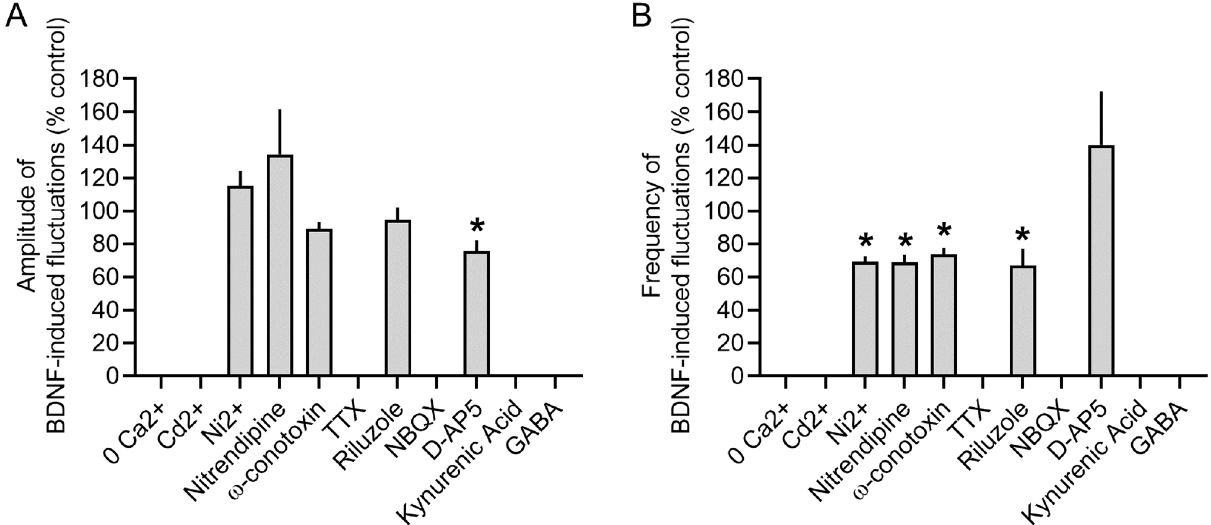
Figure 4. Pharmacology of [Ca 2+ ] i fluctuations from BDNF-treated cultures. Summary of the effects of various pharmacological treatments on the ( A ) amplitude and ( B ) frequency of the [Ca 2+ ] i fluctuations in BDNF-treated cultures compared to before drug treatment. Bars show the mean + standard error of the mean. * P < 0.001, paired t-test, n = 5–20 cells per